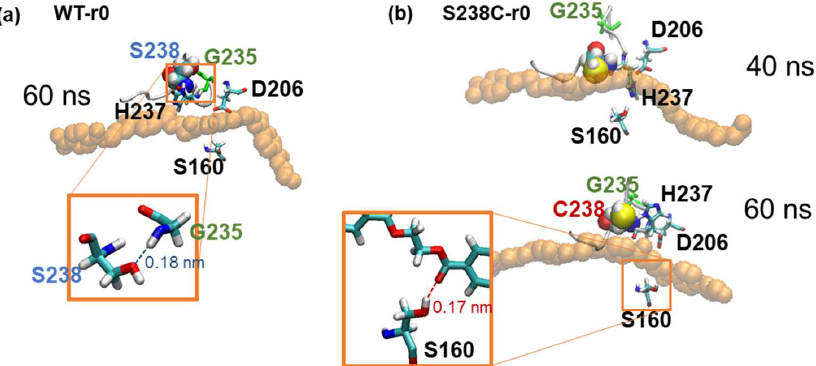
Figure 10. Effect of mutations on the binding pocket. ( a ) A sample snapshot taken from the WT-r0 MD simulation after 60 ns, ( b ) sample snapshots taken from the S238C-r0 MD simulation after 40 ns (top) and 60 ns (bottom). The PET tetramer was represented in orange. All three catalytic residues (S160, D206, and H237) were highlighted along a glycine residue 235 and the mutated residue 238.